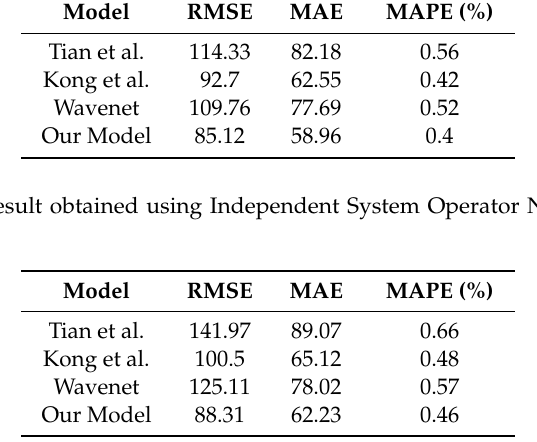
Table 4. Forecasting result obtained using Independent System Operator New England (ISO-NE) testing dataset 1.